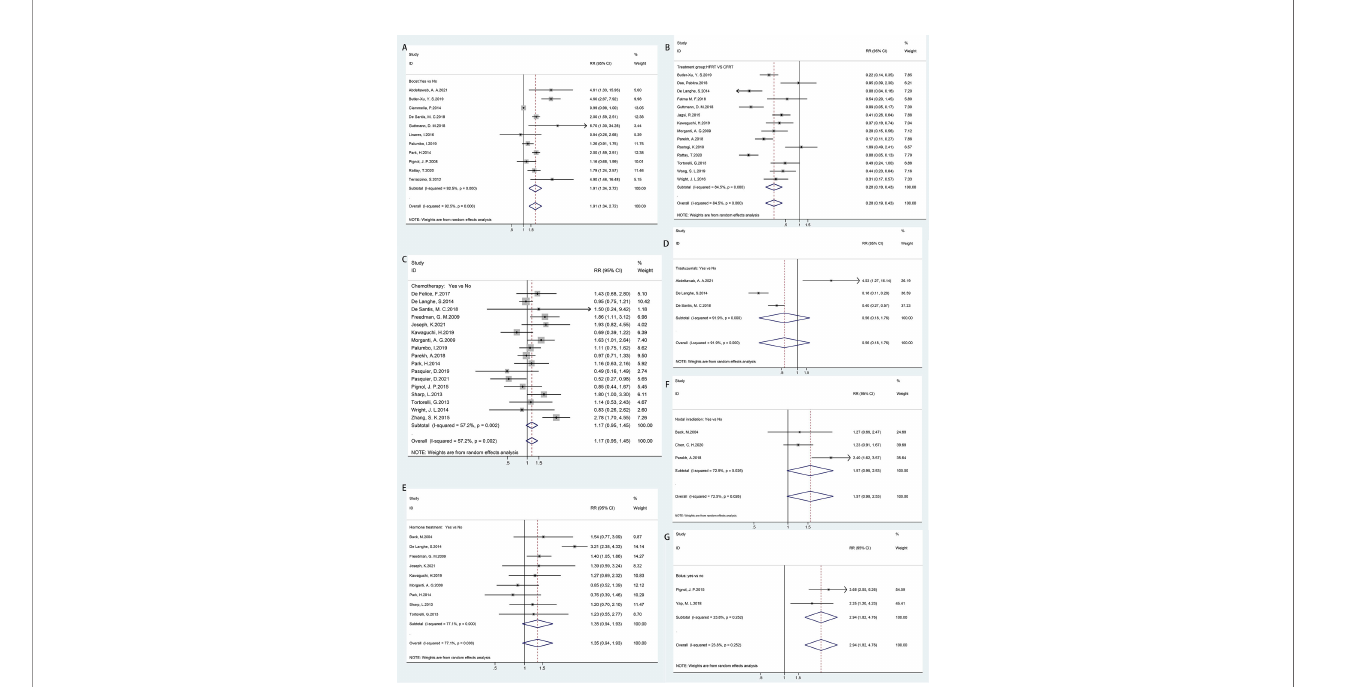
FIGURE 3 | Forest plot of studies among treatment-related risk factors associated with acute radiation dermatitis. (A) Boost. (B) Hypofractionated radiotherapy (HFRT) vs. conventional fractionated radiotherapy (CFRT). (C) Chemotherapy regimen. (D) Trastuzumab therapy. (E) Hormone therapy. (F) Nodal irradiation. (G)